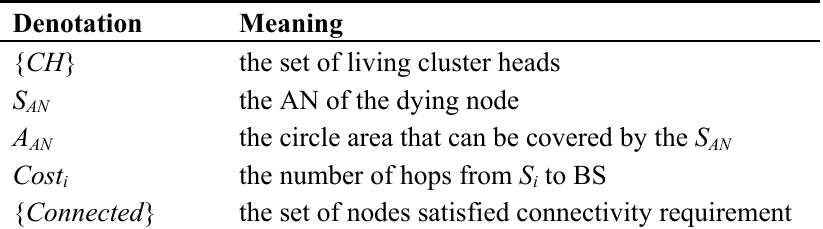
Table 2. Denotations in AN’s Reconfiguration.